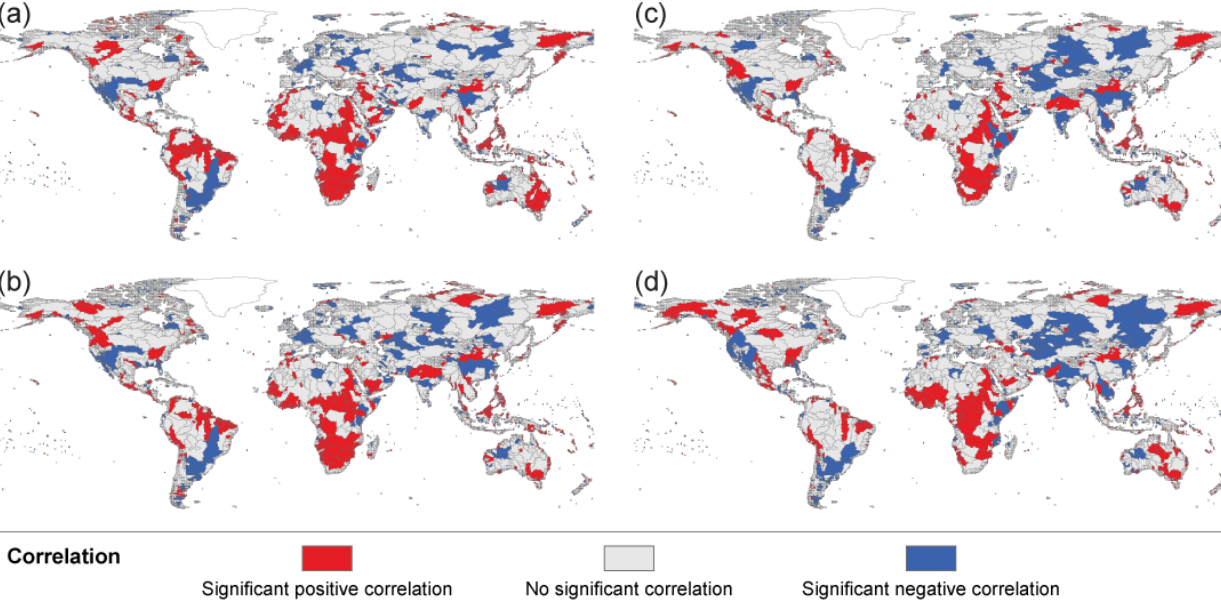
Fig. A5. Basins for which there is significant or no significant correlation between ln Q max and various indices of ENSO: (a) SOI; (b) inverse Multivariate ENSO Index (MEI); (c) inverse NINO3.4 index; and (d) inverse Global SST ENSO index. Statistical significance was tested using the t statistic ( α = 0 . 10).